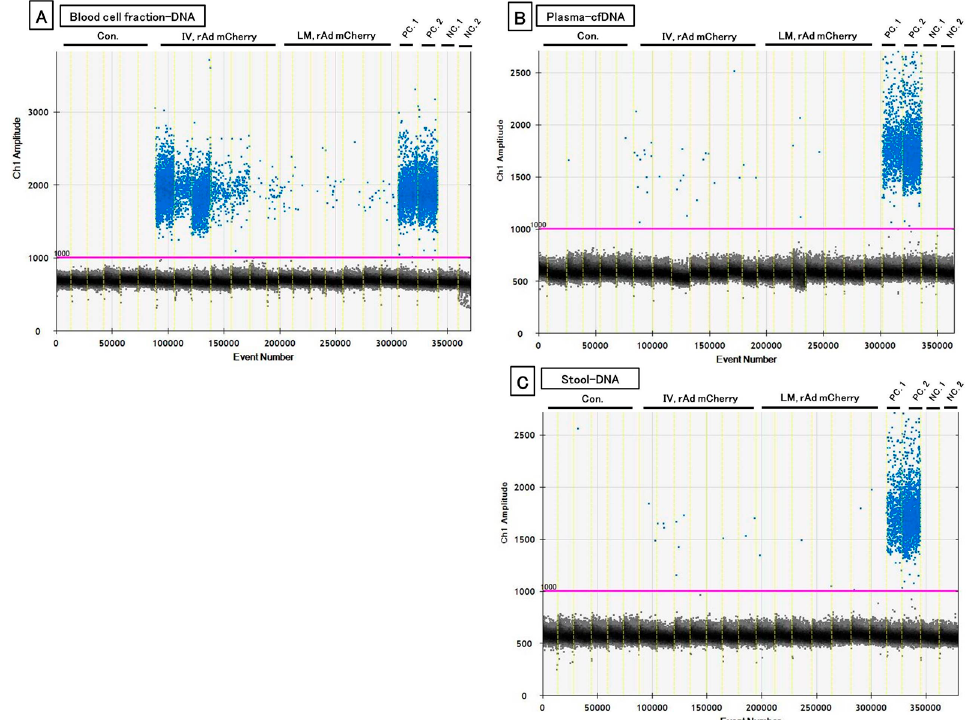
Figure 4. One-dimensional (1-D) plot data showing the detected transgene in each specimen by droplet digital PCR (ddPCR) reactions. ( A ) Blood cell fraction DNA. ( B ) Plasma plasma cell-free DNA (cfDNA). ( C ) Stool DNA. The blue plots denote positive and black ones denote the negative existence of transgene fragments. IV means intravenous injection, and LM means local muscular injection of the rAdV in the tibialis anterior (TA) muscle. PC. 1: positive control of rAdV DNA containing the mCherry gene (10 pg/µL). PC. 2: positive control of liver DNA with induced rAdV containing the mCherry gene (10 ng/µL). NC. 1: negative control of mouse DNA (50 ng/µL). NC. 2: distilled water (DW) as a negative control.